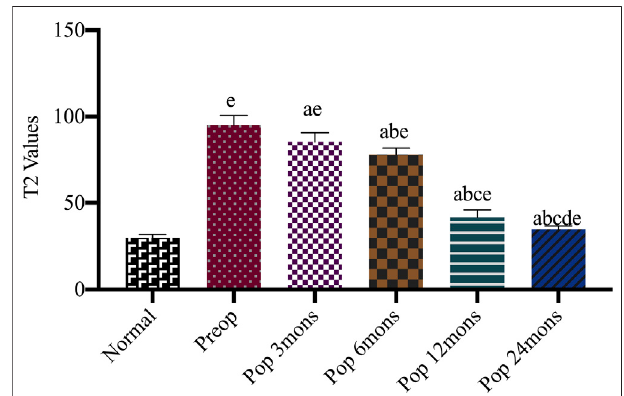
FIGURE 5 | Comparison T2 values of repaired site and surrounding normal cartilage after the operation. Preop, preoperation; Posop, postoperation; mons, months; a, p < 0.05 (vs. preoperatively); b, p < 0.05 (vs. three mons); c, p < 0.05 (vs. six mons); d, p < 0.05 (vs. 12 mons); e, p < 0.05 (vs. normal